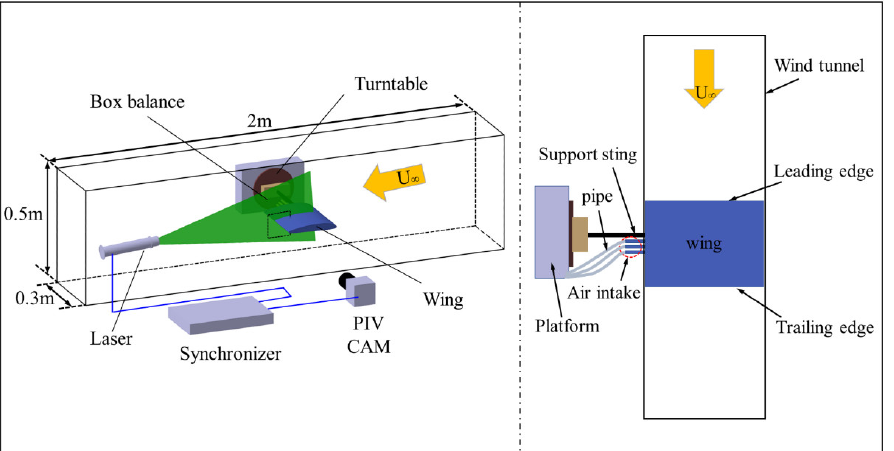
Figure 2. Wind tunnel experiment system and experiment arrangement.